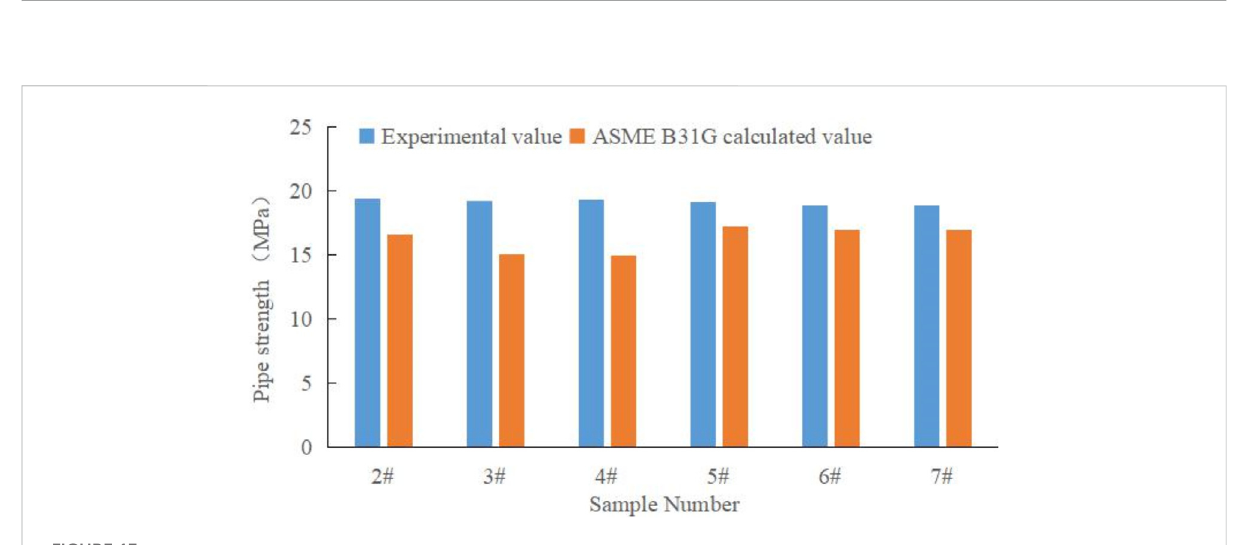
FIGURE 13 Comparisons between the calculated residual strength and the experimental